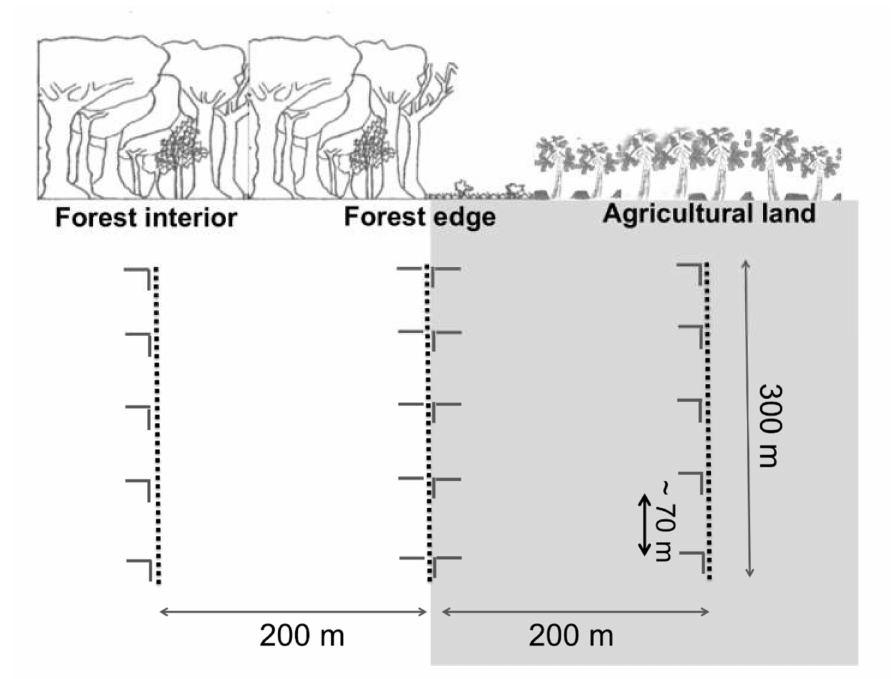
Figure 2. Sampling design. Dotted lines represent transects in each vegetation type. Solid short lines represent mist-nets. Dashed line represents the Interoceanic